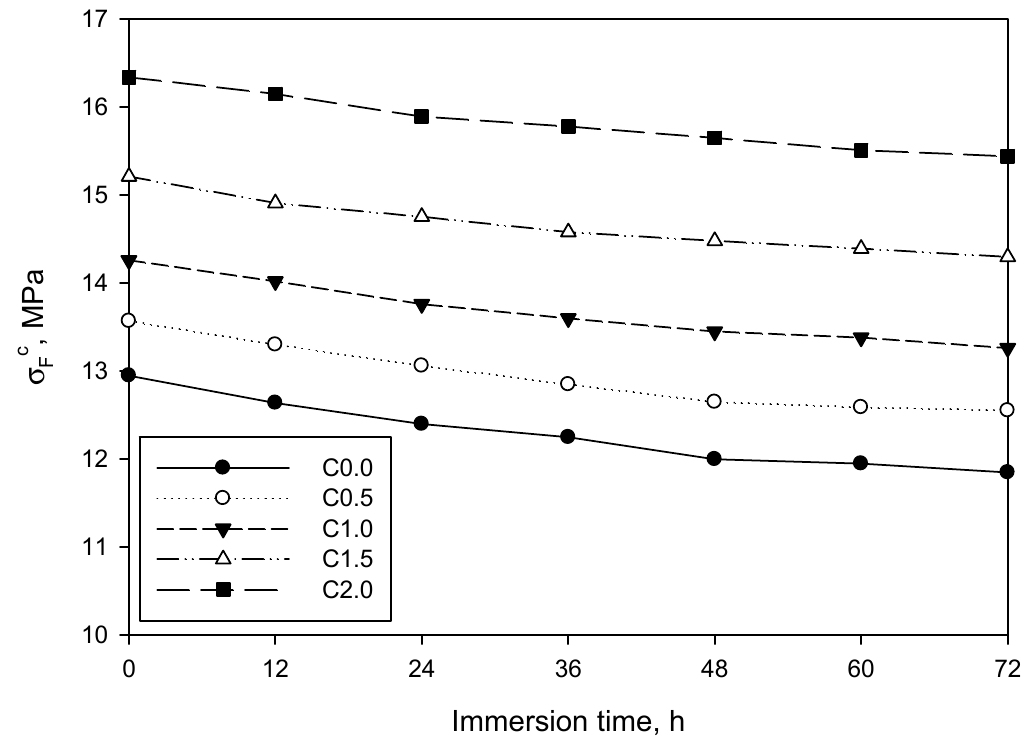
Figure 6. Evolution of flexural strength as immersion time was increased. Tests were performed every 12 h and lines between dots merely connect the data series. Materials 2019 , 12 , x FOR PEER REVIEW 8 of 14